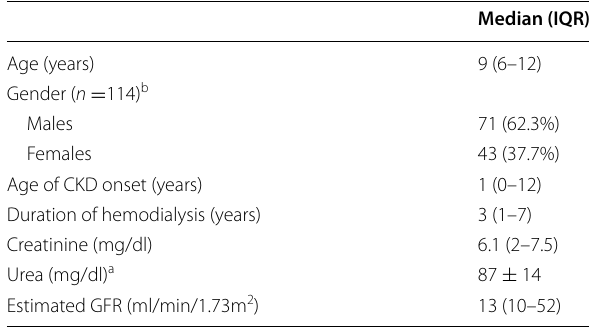
Table 2 The demographic and laboratory findings of the studied